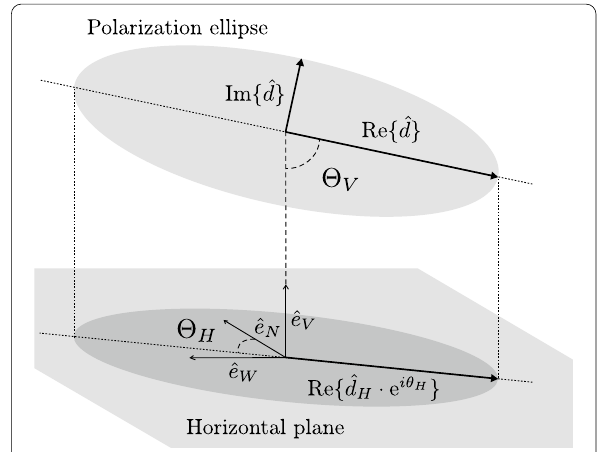
Fig. 14 Schematic illustration of polarization angles (cid:31) H and (cid:31) V based on (Park et al.